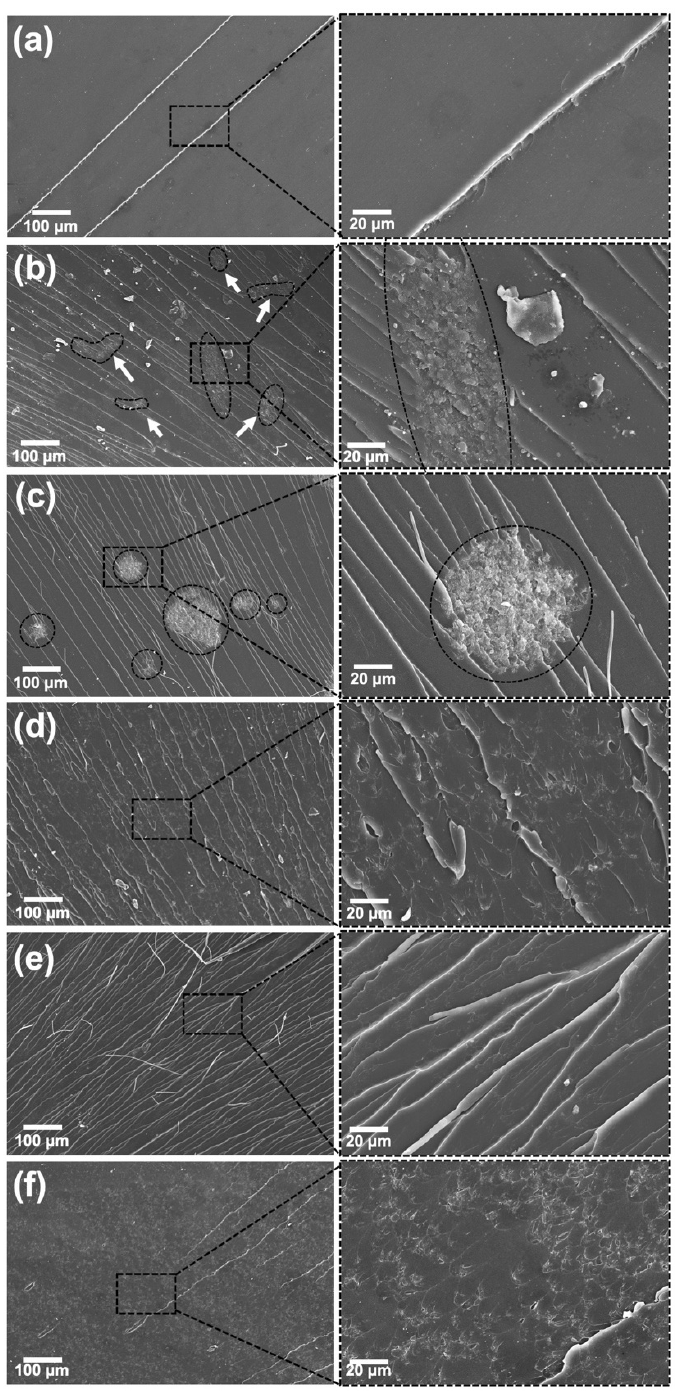
Figure 6. ( a ) SEM images of the cryofractured neat epoxy at different magnifications. Smooth fractured surfaces are typical of brittle-like failures; ( b ) CNT-filled nanocomposites at 0.25 wt.%, prepared without sonication; ( c ) with indirect sonication for 120 min; and with direct sonication for 60 min at 25% amplitude ( d ), 50% amplitude ( e ) and 75% amplitude ( f ). CNT bundles are highlighted.